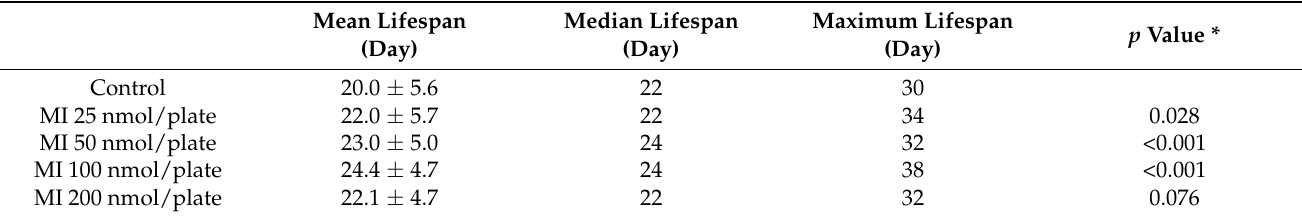
Figure 1. Effects of the myo-inositol (MI) on the lifespan of wild-type C. elegans . The nematodes (90 worms per group) were grown on plates containing different dosages of MI (0, 25, 50, 100, and 200 nmol/plate) as described in Methods. The results are from a representative experiment out of two independent experiments. Table 1. Effect of myo-inositol (MI) on the lifespan of the C. elegans .